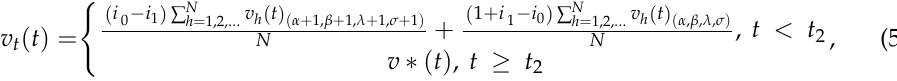
v ( t ), β E vc ( t ), λ 1